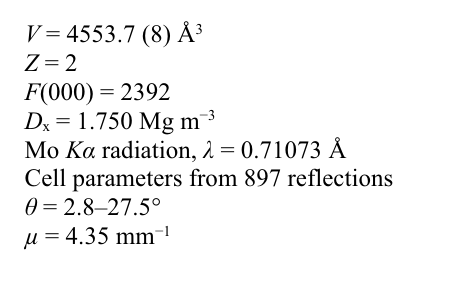
The crystal structure of the title compound, viewed along the a axis. Dashed lines represent hydrogen bonds. Tetrakis[4-(3-carboxy-1-ethyl-6-fluoro-4-hydroxonio-1,4-dihydro-7-quinolyl)- 1-methylpiperazin-1-ium] di- µ chlorido-bis[tetrachloridobismuthate(III)] tetrachloride octahydrate Crystal